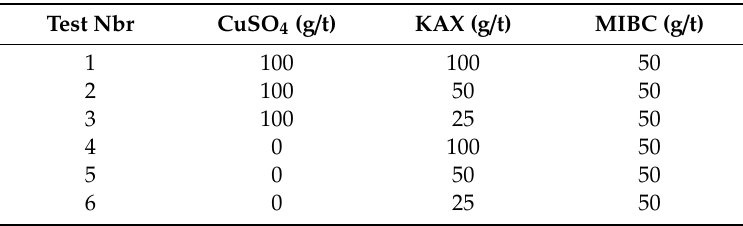
Table 1. Reagents used in the flotation